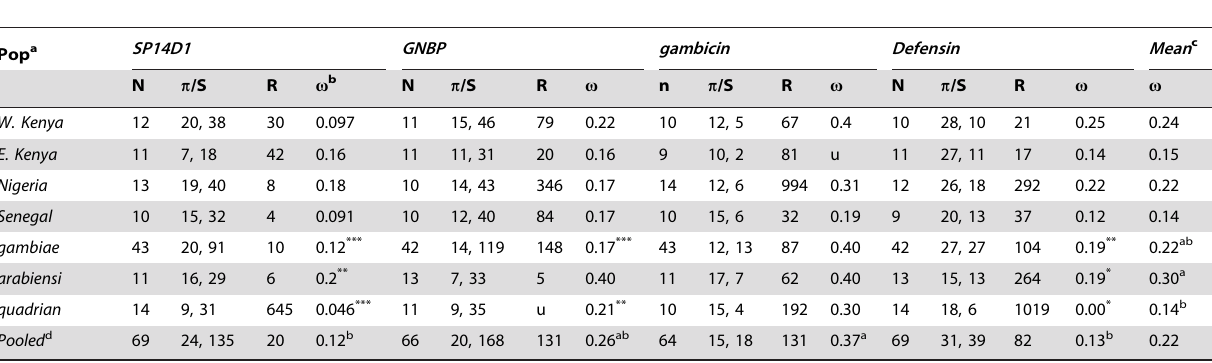
Table 3. Nucleotide diversity ( p 6 10 2 3 ), number of polymorphic sites (S), recombination parameter between adjacent position (R=4Nr) 6 10 2 3 , and ratio of nucleotide diversity in nonsynonymous/synonymous sites ( v = K a /K s ) in coding regions in each population.